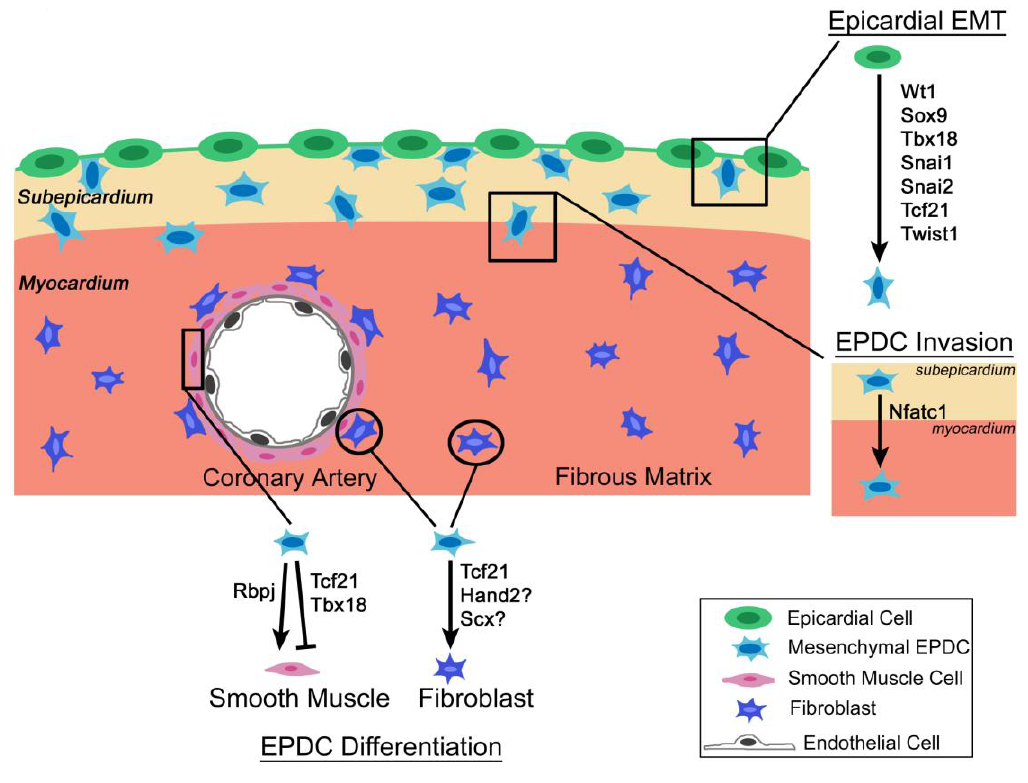
Figure 1. Schematic depicting transcription factor regulation of epicardial cells during embryonic heart development. Several transcription factors are expressed during epicardial epithelial-to-mesenchymal transition (EMT), epicardium-derived cell (EPDC) lineage specification, and EPDC differentiation into vascular smooth muscle cells and cardiac fibroblasts. See text for details and